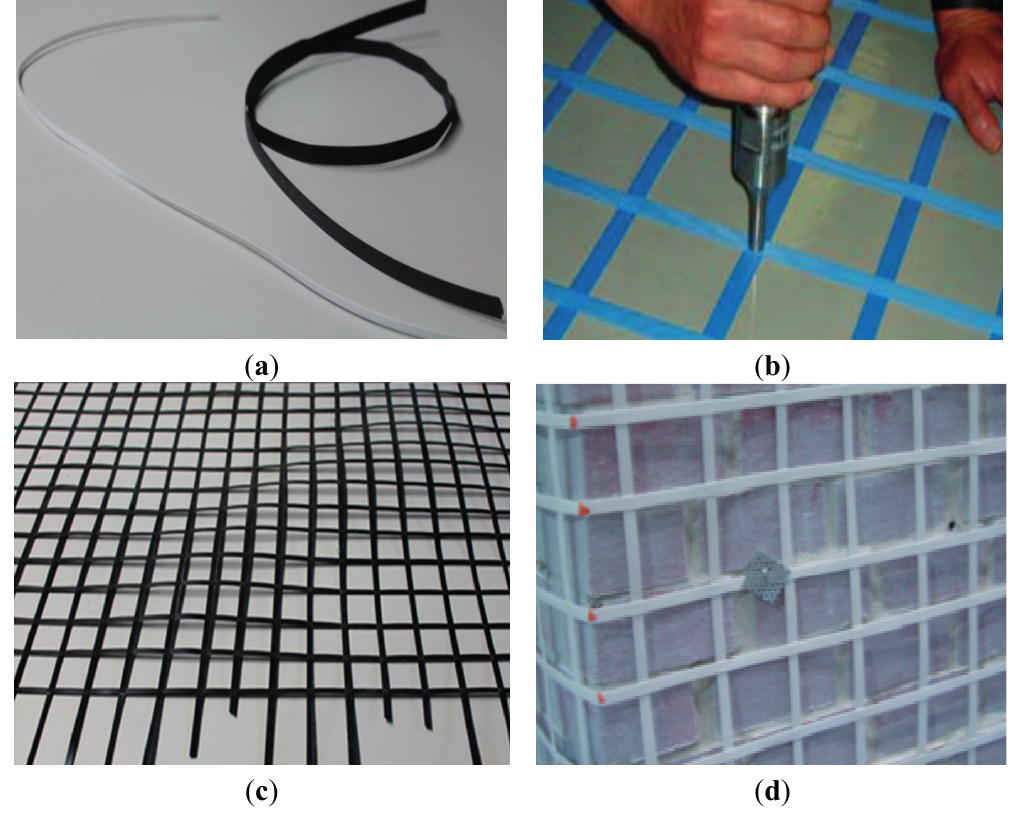
Figure 9. Retrofitting of masonry walls using PP-band mesh: ( a ) Unbonded and untensioned PP-band, ( b ) ultrasonic welding of PP-bands, ( c ) PP-band mesh prepared by ultrasonic welding machine, and ( d ) out-of-plane connection of PP-band